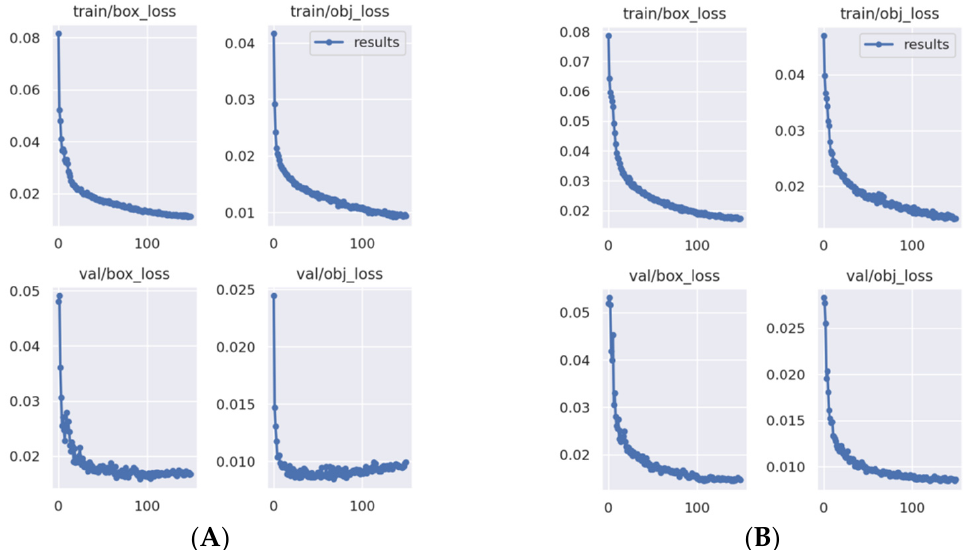
Figure 12. Training loss function value curves. YOLOv5 loss function curve ( A ) and YOLOv5-GAP loss function curve ( B ). Abscissa, iteration times and ordinate, loss value.